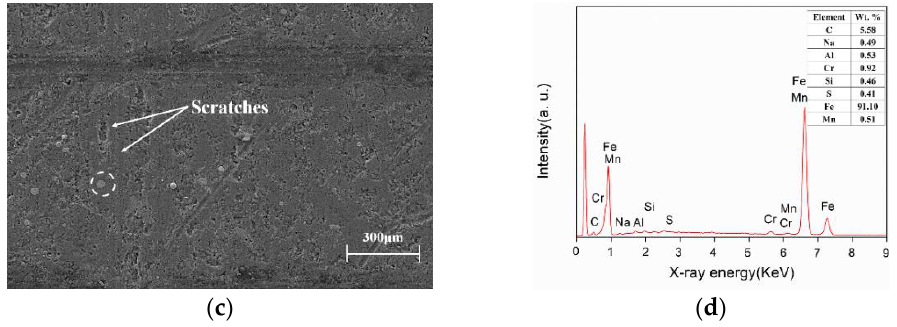
Figure 12. Typical SEM images and EDS spectra of the worn piston skirt under varied loads: ( a ) and ( c ) surface morphologies of the worn piston skirt under 8 and 10 kN, respectively; ( b ) and ( d ) EDS spectra of the wear debris observed in ( a ) and ( c ), respectively (circled in white).